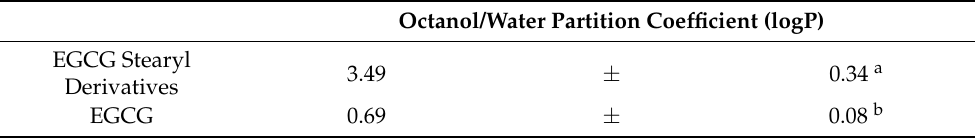
Table 2. Lipophilicity of EGCG Stearyl Derivatives and Parent EGCG.